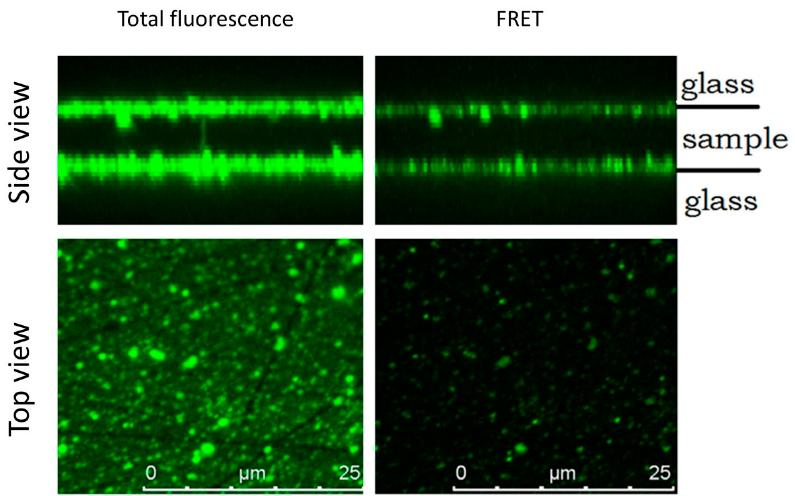
Figure 4. Fluorescent confocal microscopy images. The top view and reconstruction of the side view in the channels of general fluorescence (excitation at 532 nm, emission registration at 533–778 nm) and the FRET fluorescence (excitation at 532 nm emission registration at 650–778 nm) are